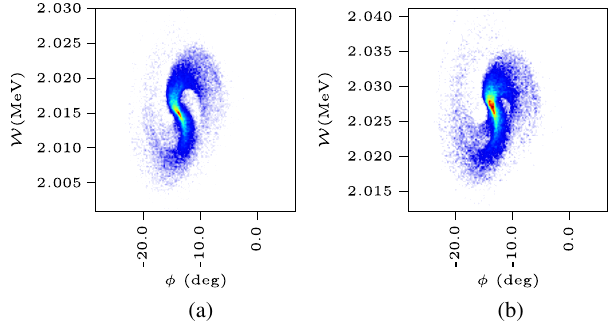
FIG. 16. Longitudinal phase spaces at the output matching plane produced by PARMTEQ (a) and after tracking through a field map generated from the same eight-term potential function using T RAVEL